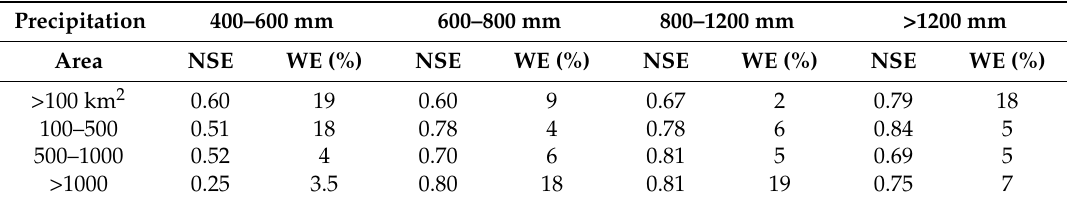
Figure 6. Changes of NSE and WE with the watershed sizes ( top ) and annual precipitation ( bottom ). Table 5. Model performance with NSE on streamflow prediction for watersheds with various sizes and precipitation quantities.